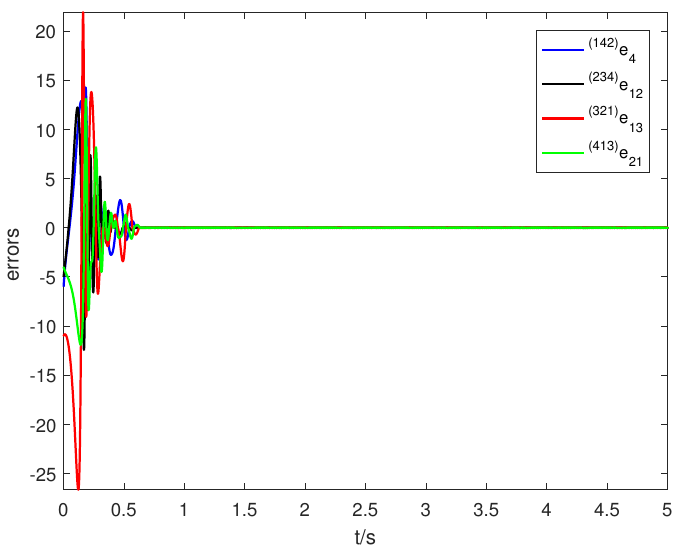
Figure 11. The synchronization errors ( 142 ) e 4 , ( 234 ) e 12 , ( 321 ) e 13 , ( 413 ) e 21 change with time t .